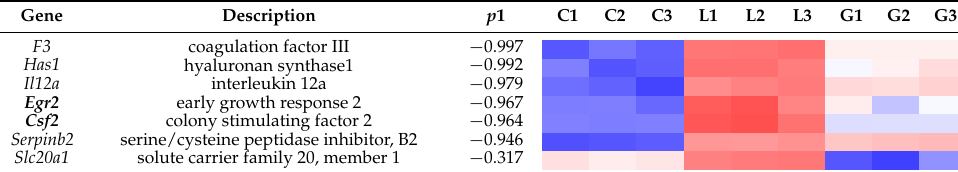
Table 2. Heat map of the genes highlighted in Figure 2B.